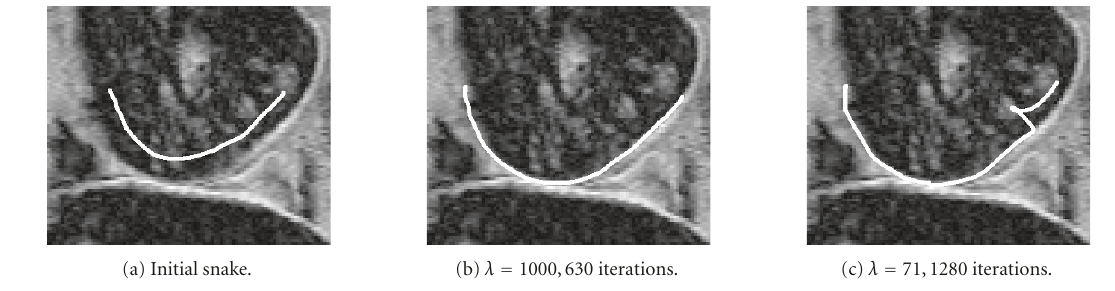
Figure 11: MRI image of a guinea-pig knee and an initial 67 points snake.